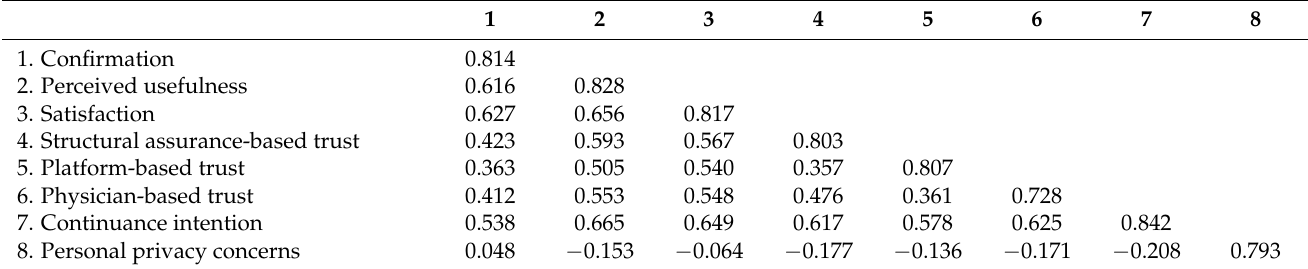
Table 3. Correlation and square root of the AVE table.